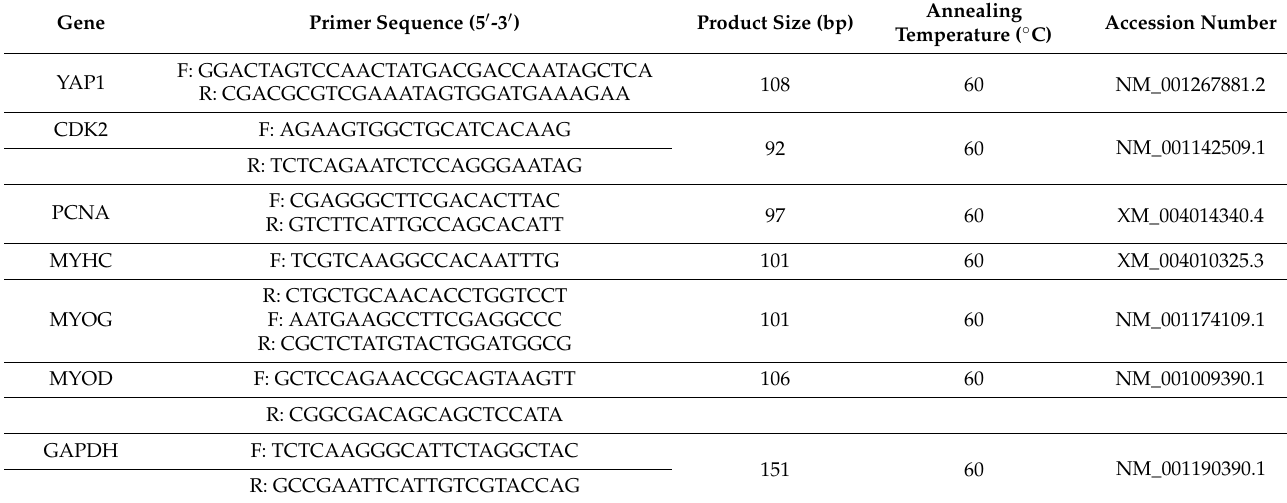
Table 2. Gene primers used for